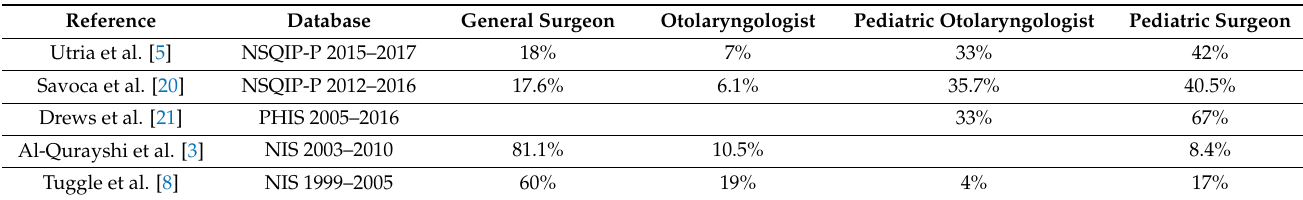
Table 2. Who is performing pediatric